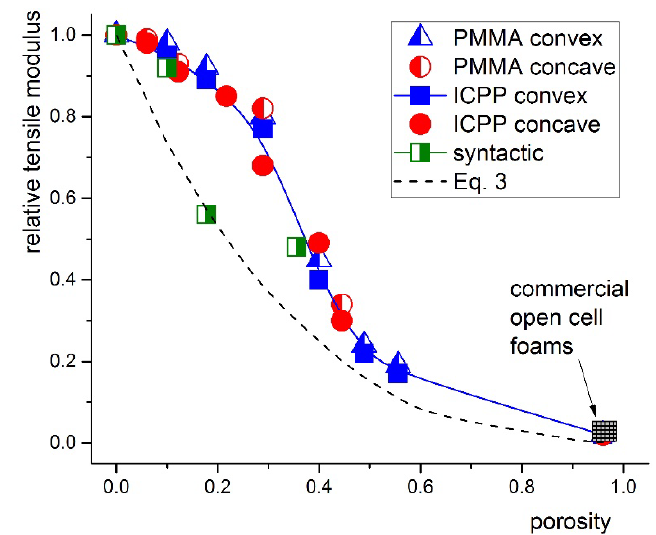
Figure 6. Dependence of the relative tensile modulus of the cellular composites with gradient porosity and commercial syntactic foams on the relative porosity. Dashed line represents the modified Ashby–Gibson model (Equation (3)). Solid blue line is the guide for the eyes only. Data for commercial, soft, and open cell foams are shown in the meshed box.